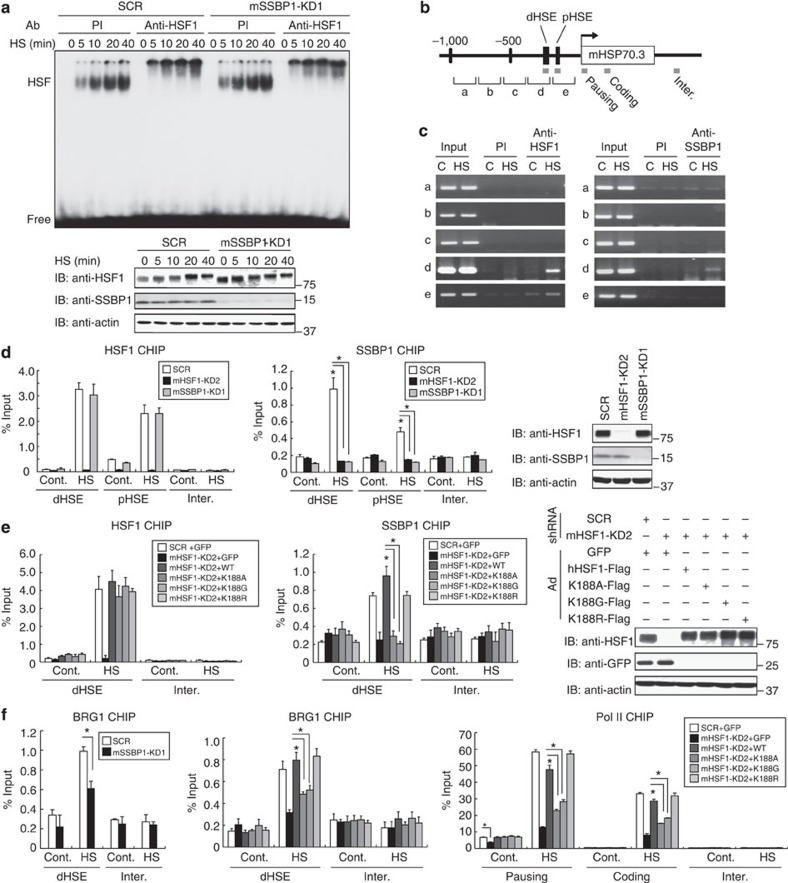
HSF1–SSBP1 complex promotes recruitment of BRG1.(a) SSBP1 does not affect DNA-binding activity of HSF1. MEF cells were infected for 72 h with Ad-sh-mSSBP1-KD1 or Ad-sh-SCR, and heat-shocked at 42 °C until 40 min (HS). Whole-cell extracts were prepared and subjected to EMSA using a 32P-labelled ideal HSE-oligonucleotide in the presence of preimmune serum (PI) or HSF1 antibody (Anti-HSF1; upper). Western blotting was performed (lower). (b) Schematic representation of mouse HSP70.3 (HSPA1A) locus. Regions a–e in the HSP70.3 promoter were amplified by PCR using primer sets. Amplified proximal and distal HSE regions (pHSE and dHSE), and coding (coding) and intergenic regions (inter.) by real-time PCR are shown as grey boxes. (c) SSBP1 is recruited to dHSE containing region. ChIP-enriched DNA was prepared, using preimmune serum (PI) or antibody for HSF1 or SSBP1, from MEF cells untreated (C) or treated with heat shock at 42 °C for 30 min (HS). DNA fragments of the regions were amplified by PCR. (d) HSF1-dependent recruitment of SSBP1. MEF cells, in which HSF1 or SSBP1 was knocked down, were treated without (Cont.) or with heat shock at 42 °C for 30 min (HS). ChIP-qPCR analyses were performed in pHSE, dHSE and intergenic (Inter.) regions using HSF1 or SSBP1 antibody (n=3). Mean±s.d. is shown. Asterisks indicate P<0.05 by Student’s t-test. HSF1 and SSBP1 protein levels were examined by western blotting. (e) SSBP1 occupancy in the presence of HSF1 mutants. Cells, in which endogenous HSF1 was substituted with each interaction mutant, were untreated (Cont.) or treated with heat shock at 42 °C for 30 min (HS). ChIP-qPCR analyses were performed (n=3). Protein levels of HSF1 and its mutants were examined by western blotting. (f) SSBP1 promotes the recruitment of BRG1 and Pol II. SSBP1 knockdown cells were heat-shocked as described in d, and ChIP-qPCR analyses were performed using BRG1 antibody (n=3). Endogenous HSF1 was also substituted with each interaction mutant as described in e. ChIP-qPCR analyses in the dHSE and pausing, coding and intergenic regions were performed using BRG1 or Pol II antibody (n=3).